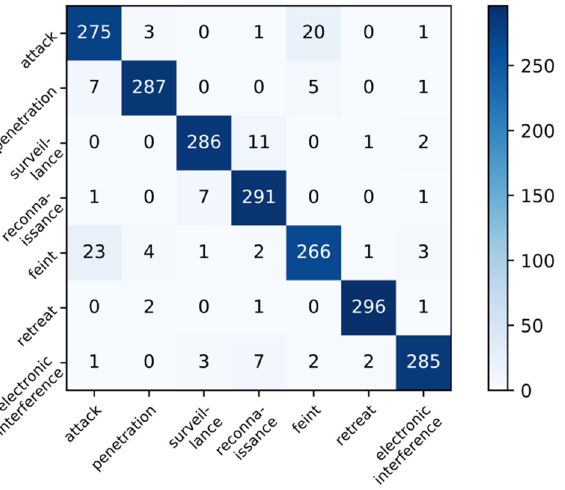
Figure 13. Confusion matrix of Attention-TCN-BiGRU intention recognition results.